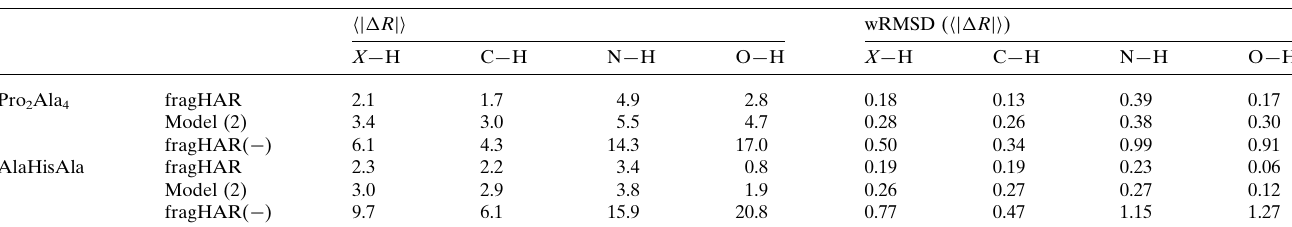
Table 1 Average bond length deviation ( hj (cid:2) R ji ) and wRMSD ( hj (cid:2) R ji ) between regular HAR and fragHAR. Fragmentation carried out using model (2) and fragHAR without point multipoles [fragHAR( (cid:5) )]. The data are grouped by bond type.